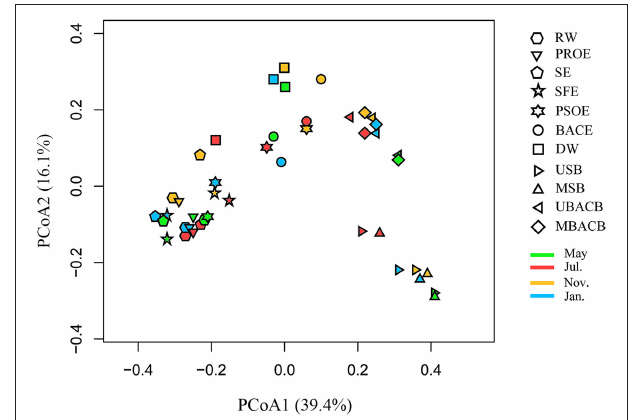
FIGURE 6 | Principal coordinates analysis (PCoA) of the samples using weighted UniFrac metrics. The abbreviations of the samples are the same as used in Table 2